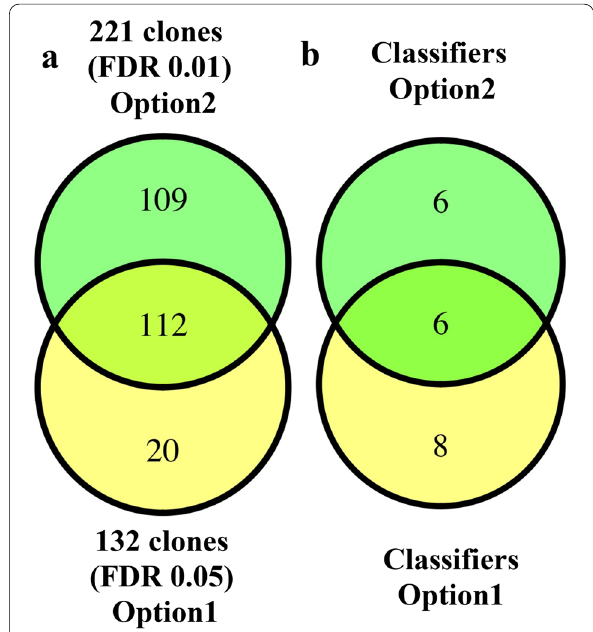
Fig. 4 Diagrammatic representation of significant clones from two approaches (option 1 and 2). a Illustrates the Venn diagram of 132 clones (FDR < 0.05) from option 1 and 221 clones (FDR < 0.01) from option 2 and their intersection. b depicts the Venn diagram of the 14 classifiers clones from option 1 and 12 clones from option